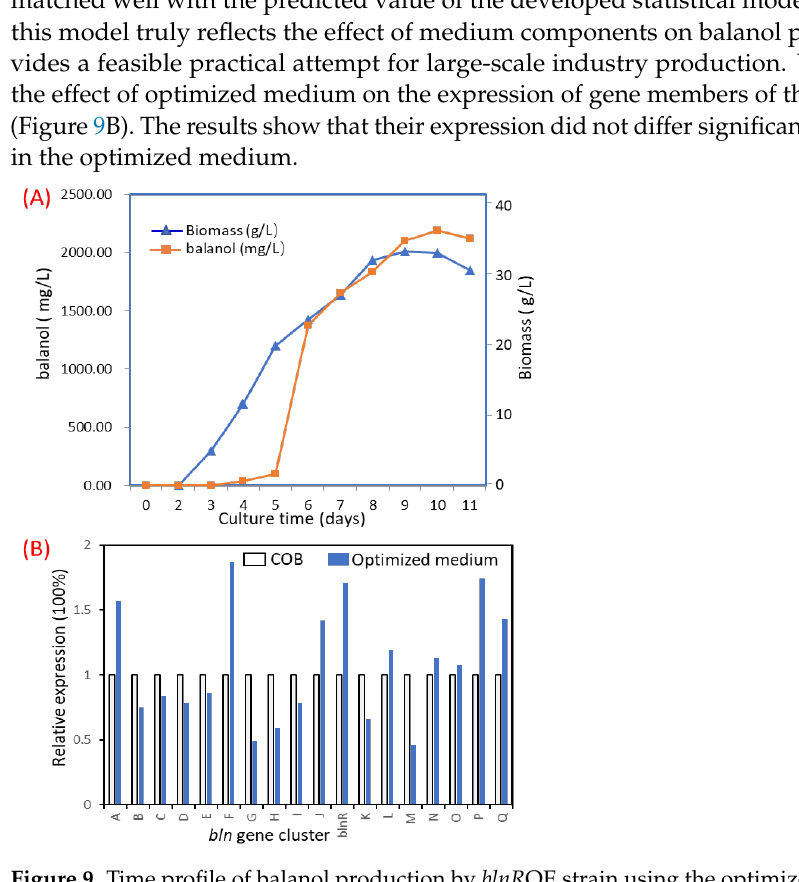
Figure 9. Time profile of balanol production by blnR OE strain using the optimized medium ( A ) and analysis of the expression level of the bln gene cluster ( B ). The blnR OE strain was cultured in a 15 L tank at 26 ◦ C for 11 days with 8 L of medium. The culture broth was sampled for analysis of cell growth by determination of dried weight and balanol production every two days. The dissolved oxygen was maintained at 30% through cultivation. For RNA extraction, 4-day mycelium was used to analyze the expression